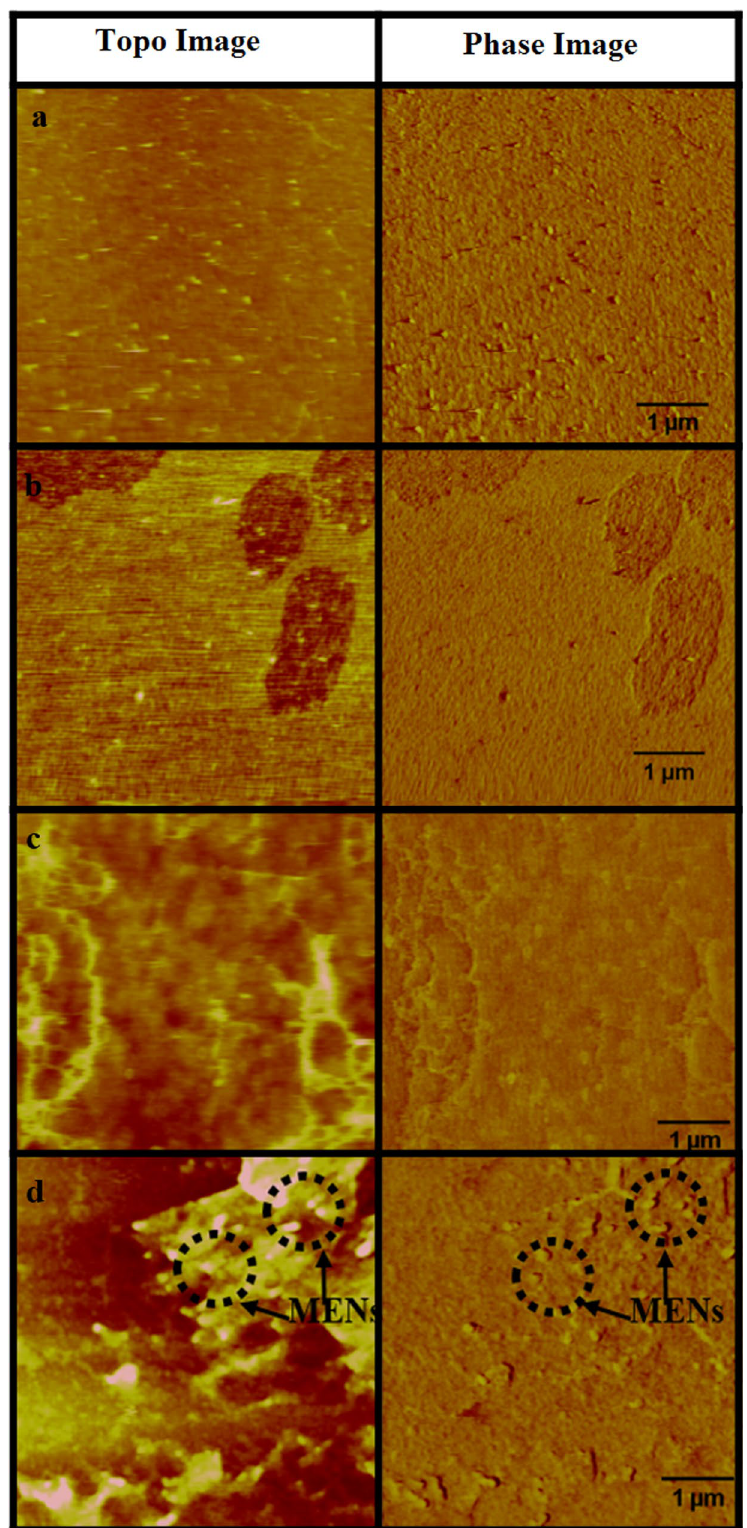
Figure 6. AFM images of the membrane surfaces of ( a ) normal brain endothelial cells, ( b ) normal brain endothelial cells with MENs at a saturated concentration ( c ) glioblastoma cells and ( d ) glioblastoma cells with MENs at a saturated concentration level. Each pair of AFM scans represent z-height and phase images, respectively. The nanoparticles are circled in dotted